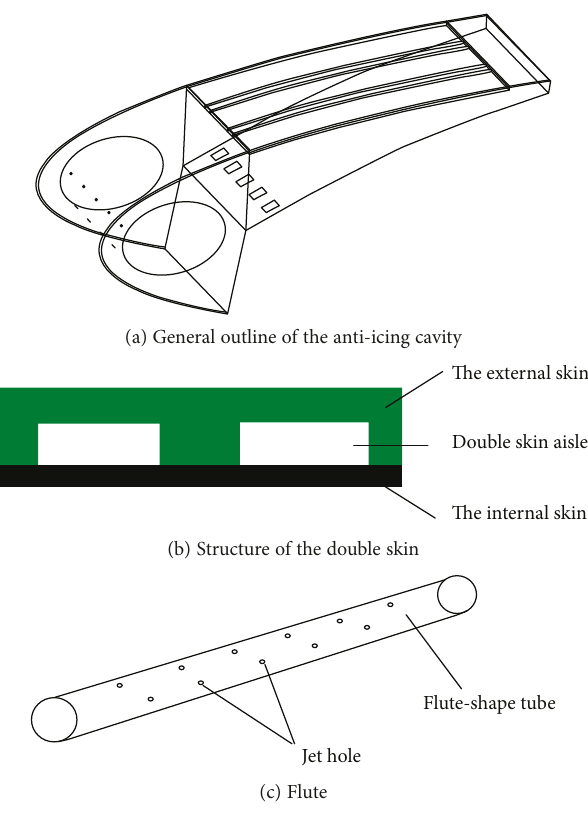
Figure 1: Sketches of the subject anti-icing cavity.